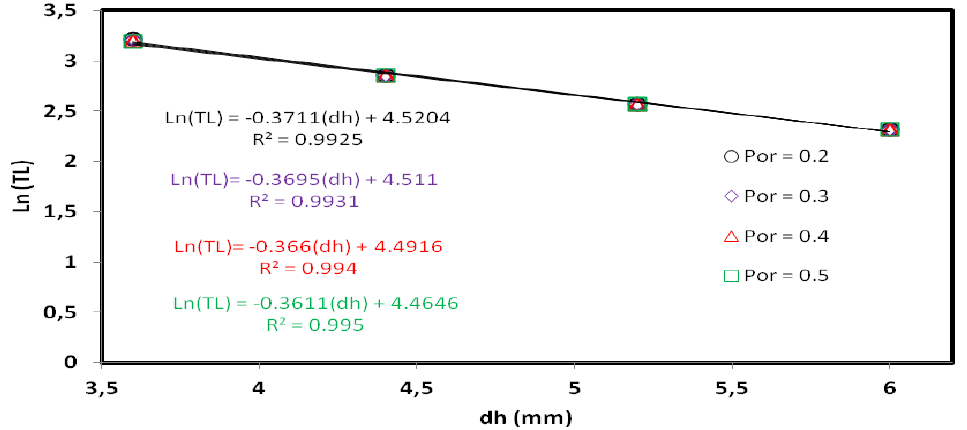
Figure 11. Change of the logarithmic toe length with the head difference for different dispersivity values over the range 0.001–0.2 cm.